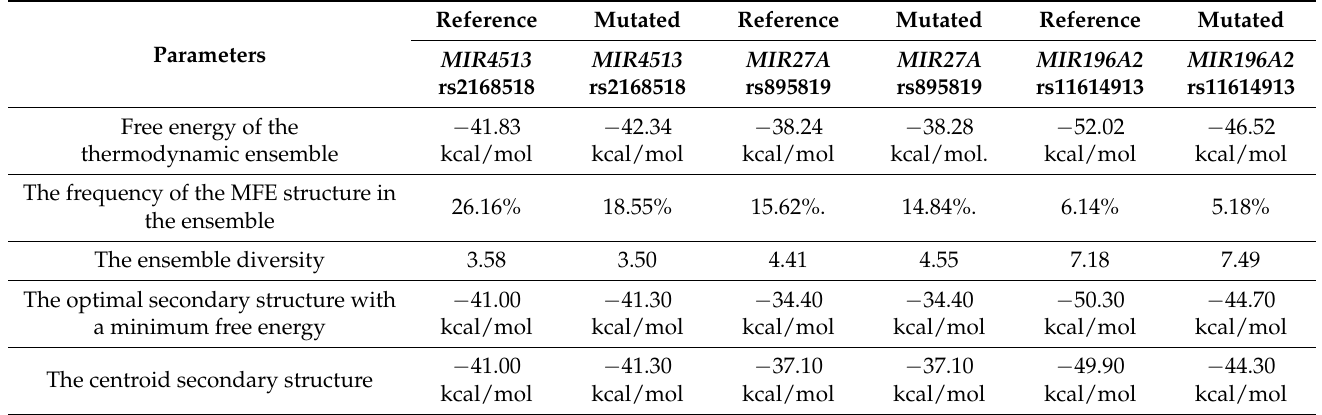
Table 4. Information about the free energy of the thermodynamic ensemble, the frequency of the MFE structure in the ensemble, the ensemble diversity, the optimal secondary structure with minimum free energy, and the centroid secondary structure of studied reference SNPs and their mutated